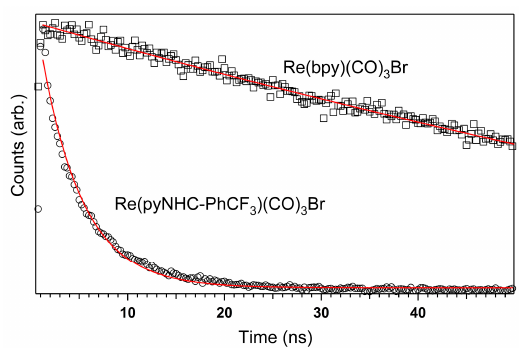
Figure 4. Time-correlated single photon counting (TCSPC) fluorescence decays of Re(pyNHC- PhCF 3 )(CO) 3 Br and Re(bpy)(CO) 3 Br. (CO) 3 Br and Re(bpy)(CO) 3